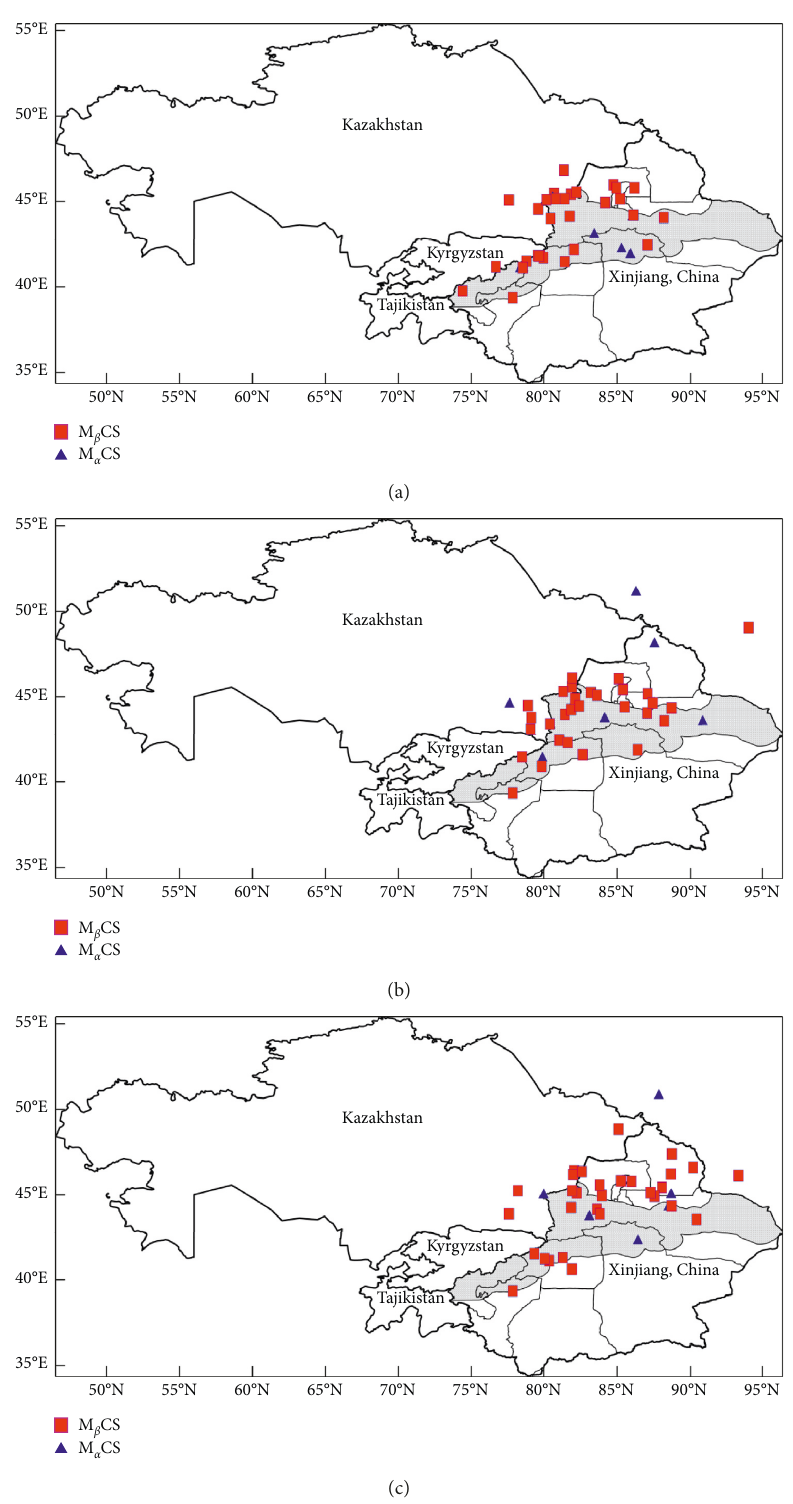
Figure 8: Spatial distribution of MCSs in the different stages: (a) formation, (b) maturity, and (c) dissipation (the shaded area represents the Tianshan Mountains and the adjacent area in